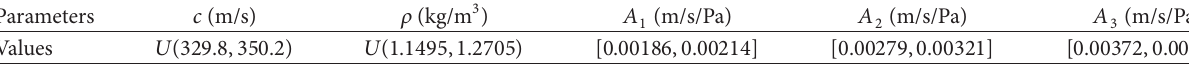
Table 5: Characteristics of the uncertain parameters of the 2D car cavity.